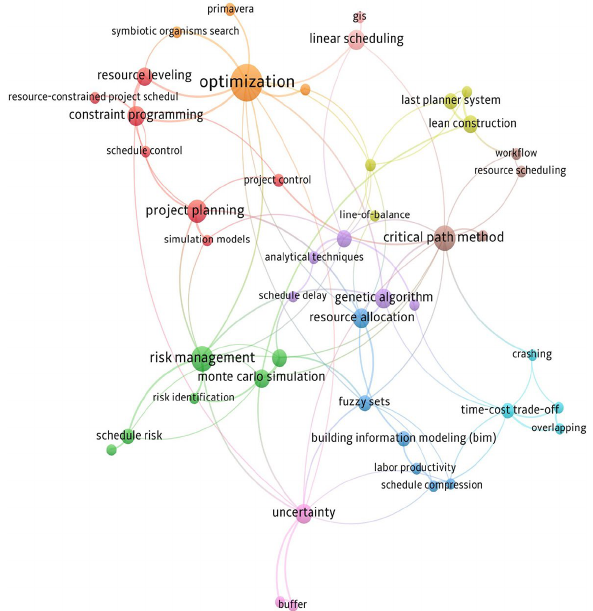
Figure 4. Bibliometric network